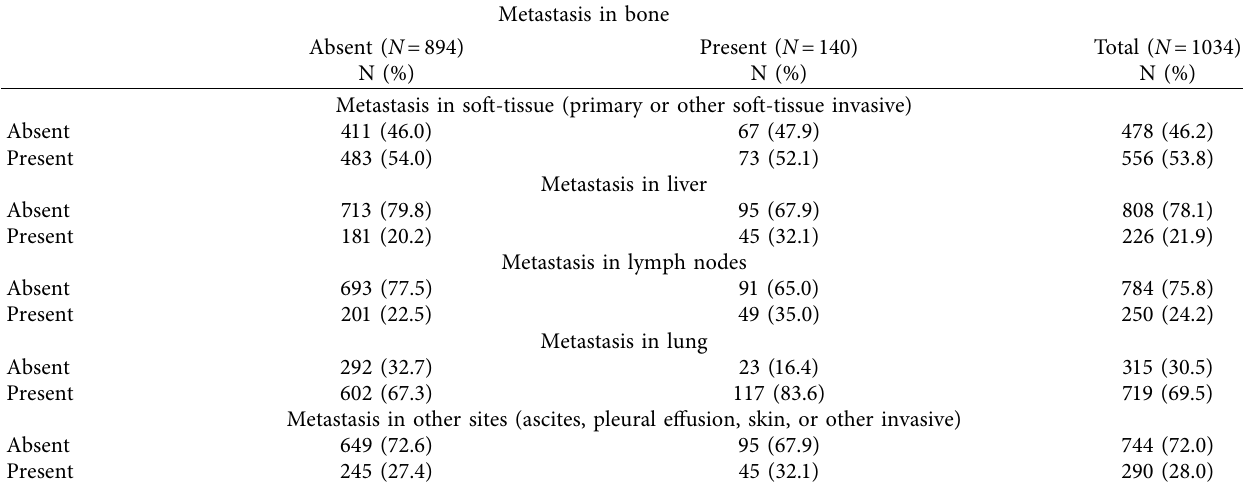
Table 2: Patient metastatic profile versus metastasis in the